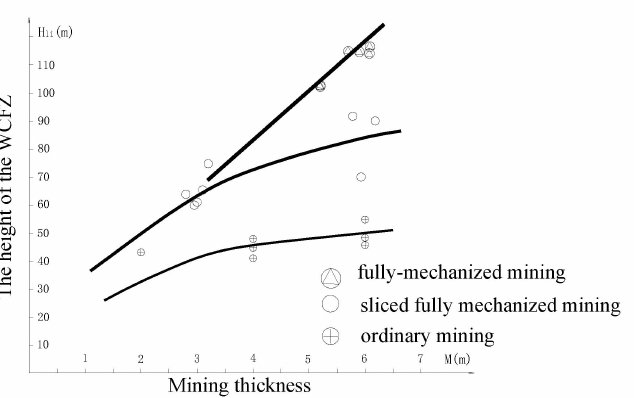
Figure 5. Relation between height of FWCZ and thickness of the same coal seam under different mining